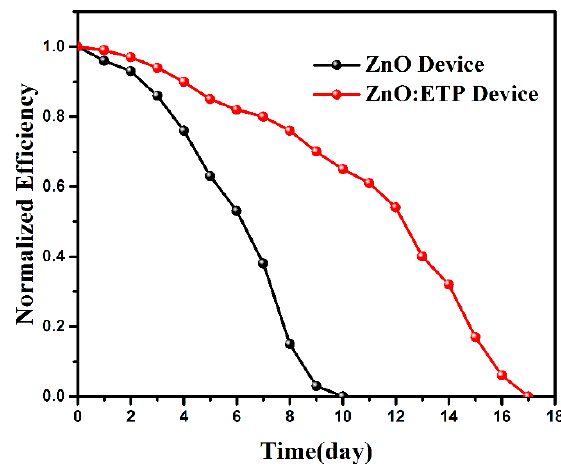
Figure 9. Power conversion efficiency (PCE) decay curves of the ZnO and ZnO/ETP device (based on PTB7-Th–PC 71 BM) stored for 17 days in an N 2 -filled glove box.